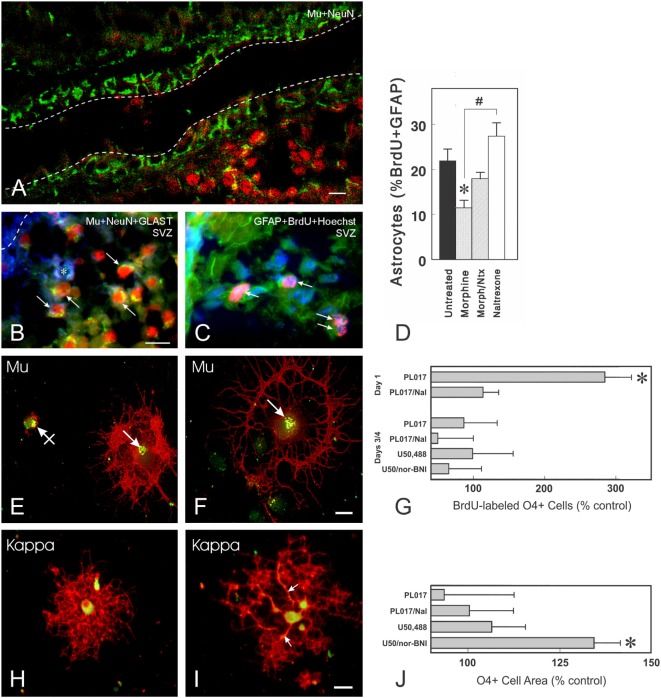
Opioid receptors can be expressed by immature neurons, astrocytes, and oligodendrocytes. (A) μ-Opioid receptor (MOR) (Mu; green fluorescence) immunoreactive cells can be present in some portions of the ventricular zone and/or subventricular zone (SVZ) of postnatal day 5 mice (scale bar = 20 µm). Many of the MOR+ cells entering the SVZ are NeuN-immunoreactive neurons (red fluorescence). The dashed lines represent the borders of the lateral ventricle. (B) Photomicrograph showing combined neuronal nuclear (NeuN; red fluorescence), glutamate transporter (GLAST, also known as excitatory amino acid transporter 1; blue fluorescence), and MOR (green fluorescence) immunofluorescence in cells from postnatal day 5 mice. Subpopulations of both neurons (arrows) and astroglia (*) express MOR. (C) Thymidine analog, 5-bromo-2′-deoxyuridine (BrdU) labeled (red fluorescence), and glial fibrillary acidic protein (GFAP+) astrocytes (green fluorescence) are indicated by the arrows (C); cell nuclei are counterstained with Hoechst 33342 (blue fluorescence) [scale bar in (B) = 25 µm; (B,C)
are the same magnification]. (D) Effect of morphine and/or naltrexone on BrdU incorporation in GFAP-expressing cells within the postnatal day 5-mouse brain. Morphine significantly decreased the proportion of BrdU+ astrocytes (*p < 0.05) and there is a significant difference between morphine-treated and naltrexone-treated mice (#p < 0.05). (E–J) Oligodendrocytes express MOR and κ-opioid receptors (KOR) in a developmentally regulated manner in vitro. Oligodendrocytes are labeled using the specific anti-O4 antibody (red fluorescence) and colocalized with MOR (E,F) or KOR (H,I) immunoreactivity. (E,F) MOR are localized within discrete perinuclear regions of the cell body (arrows) (green fluorescence); areas where O4 and MOR or KOR are colocalized display yellow fluorescence. MORs can be associated with oligodendrocytes at different stages of development, including very immature oligodendrocytes with negligible O4 immunoreactivity [crossed arrow; (E)] and more mature oligodendrocytes with large process networks [arrow; (F)] [scale bar in (F) = 10 µm; (E,F)
are the same magnification]. (G) The effect of opioid receptor agonists and antagonists on BrdU uptake in cultured O4+ oligodendrocytes of two different ages. At 1 day after enrichment, oligodendrocytes are still relatively immature and express only μ-receptors. A 27-h exposure to the MOR agonist PL017 increases BrdU uptake by nearly 300% compared with control values. In the presence of naloxone (PL017/Nal), this effect is not seen. At 3–4 days after enrichment, neither MOR nor a KOR agonist (U50,488) or antagonist [nor-binaltorphimine (nor-BNI)] affect BrdU uptake in a significant manner. Cells were counted on duplicate coverslips from 4 to 5 different cultures (*p < 0.01; ANOVA with post hoc Newman-Keuls testing). (H,I) By contrast to MOR, KOR are distributed through the entire cell body cytoplasm. Occasional oligodendrocytes also have KOR-immunoreactivity within regions along cell processes [arrows; (I)] [scale bar in (I) = 20 µm; (H,I)
are the same magnification]. (J) Effects of opioid receptor agonists and antagonists on oligodendrocyte cell area. After 48 h of exposure, the only significant effect is seen with the KOR antagonist, nor-BNI, which increased the average cell area compared with control cells (*p < 0.025) (J). This effect was not seen at 27 h (164). The finding that nor-BNI increases the elaboration of cytoplasmic processes provides circumstantial evidence that endogenous opioids are expressed and inhibit oligodendrocyte differentiation (164). Subsequent studies showed that differentiating oligodendrocytes produce dynorphins and these endogenous KOR peptide ligands appear to preferentially decrease the survival of oligodendrocytes during later maturation (165). Thus, an alternative explanation is that the loss of more mature oligodendrocytes results in a net increase in immature oligodendrocytes and the perception that dynorphin is restricting differentiation. Figures (A–D) are reprinted from Ref. (39); Copyright (2001), with permission from John Wiley and Sons. Figures (E–J) are reprinted with slight modifications from Ref. (164); Copyright (1998), with permission from John Wiley and Sons.